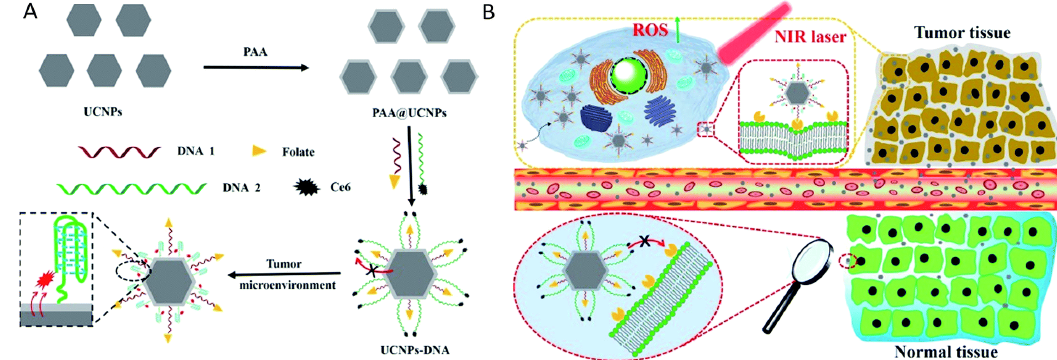
Figure 10. ( A ) Schematic preparation of UCNPs@PAA – DNA and ( B ) specific tumor targeting for PDT treatment of MCF-7 cells [148]. Published by The Royal Society of Chemistry (RSC).